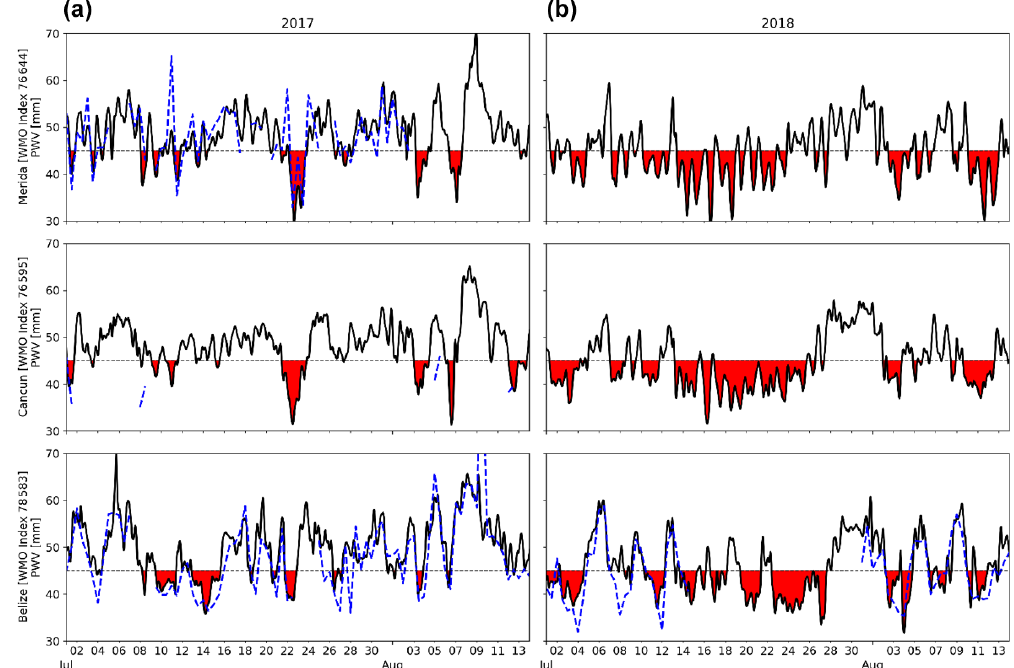
Figure 3. MERRA-2 precipitable water (black solid line) and precipitable water values estimated from radiosonde measurements (blue dashed line), for the three WMO radiosonde stations located on the Yucatán Peninsula for (a) July–August 2017 and (b) July–August 2018. The red areas represent the periods where precipitable water vapor (PWV) is less than